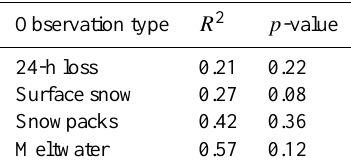
Table 10. Multiple linear regression models for